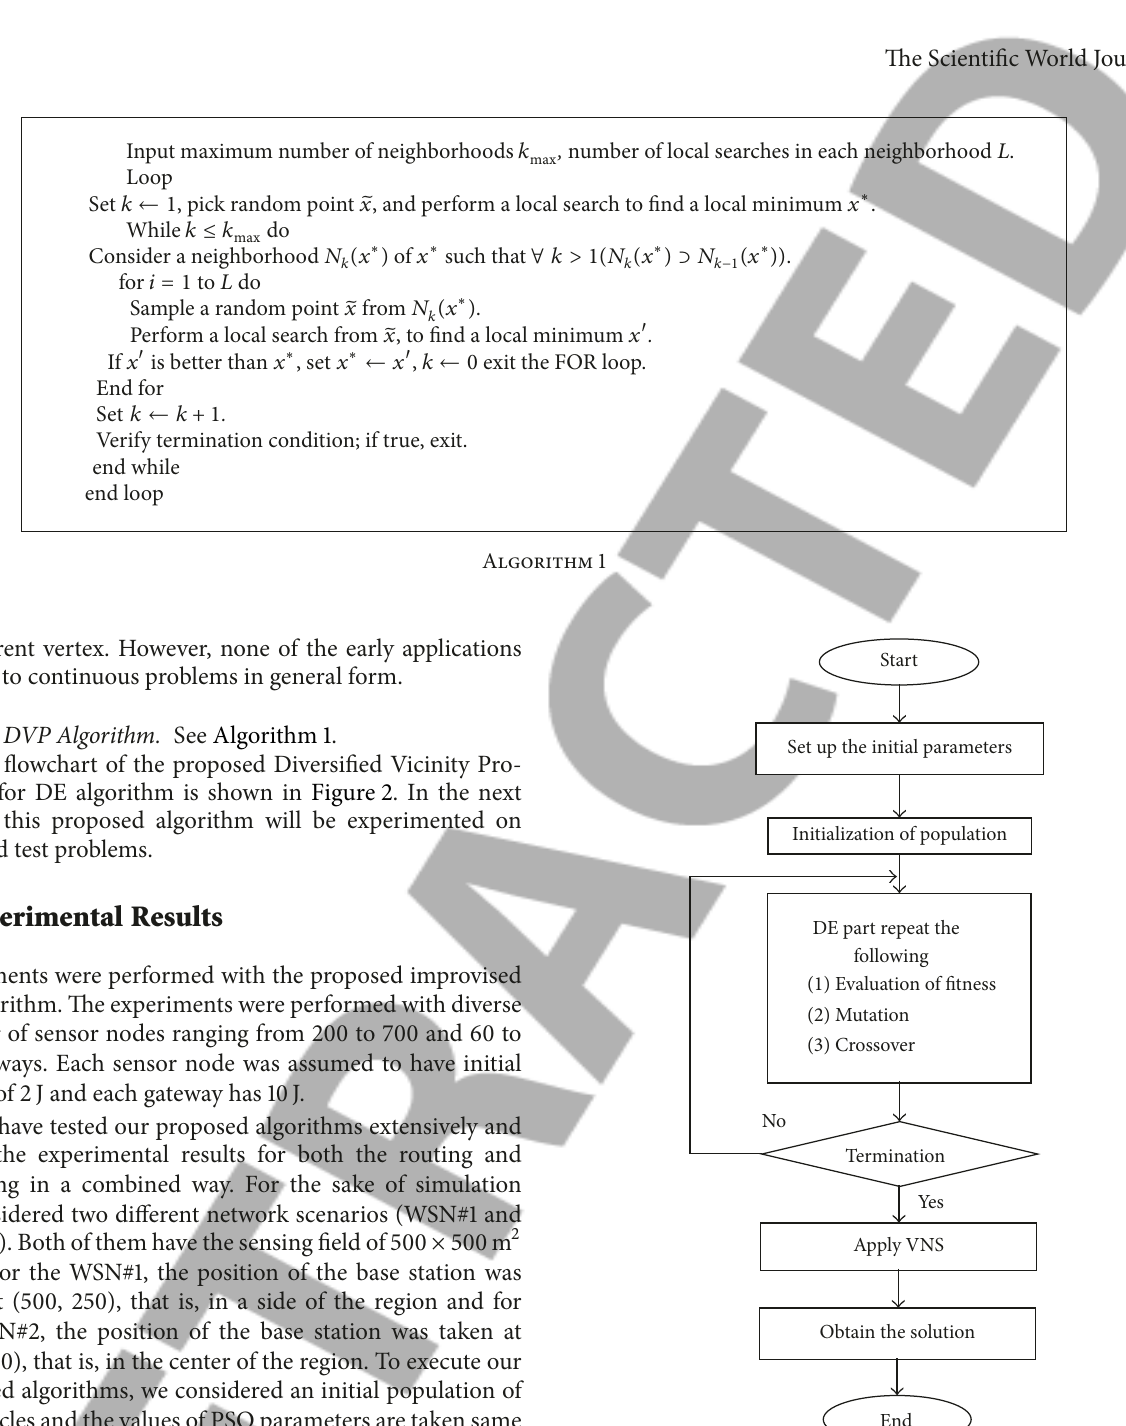
Figure 2: Flowchart of the proposed Diversified Vicinity Procedure for DE